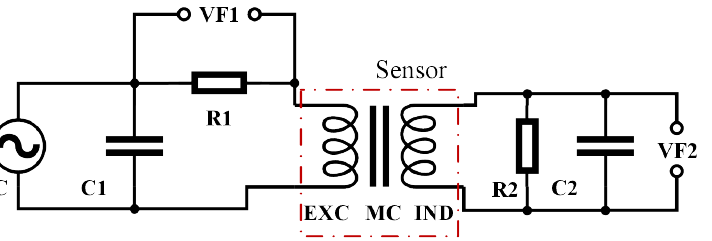
Figure 2. The test circuit of the sensor. AC represents the waveform generator and the power amplifier. C1 is the tuning capacitor. R1 is the excitation current sampling resistor. EXC is the excitation coil, MC is the magnetic core, IND is the induction coil, and the 3 components inside the dot-dashed red box as a whole represent the sensor. R2 and C2 are the loads of the induction coil. VF1 and VF2 are measuring points for